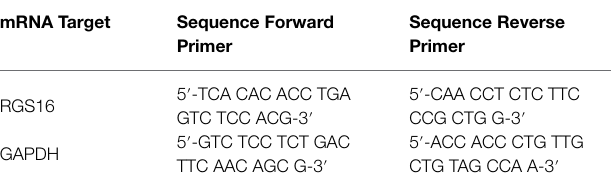
TABLE 1 | mRNA primer sequences for qPCR